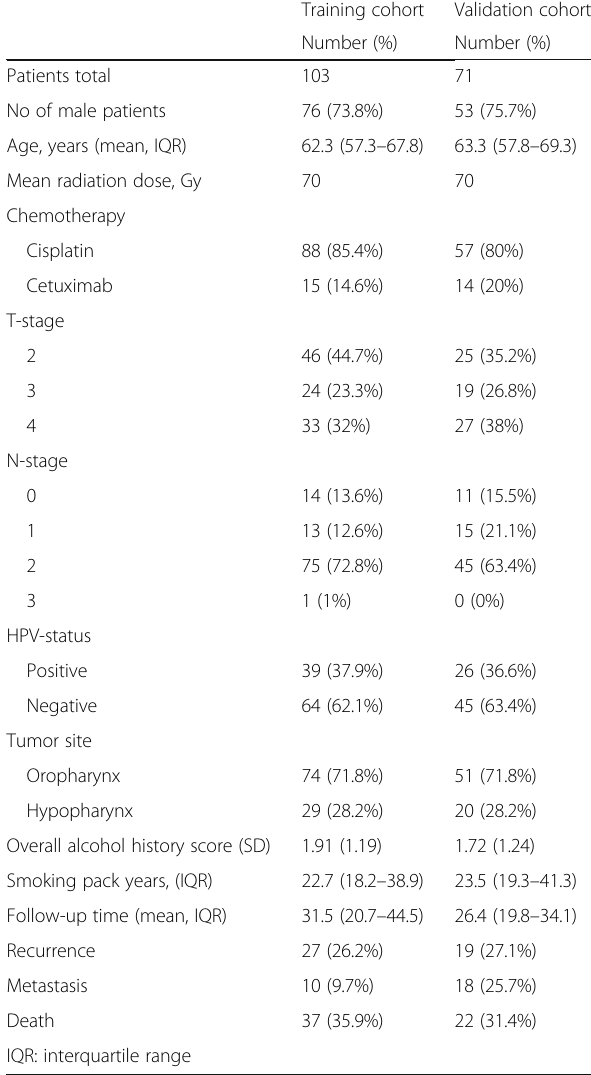
Table 1 Patient